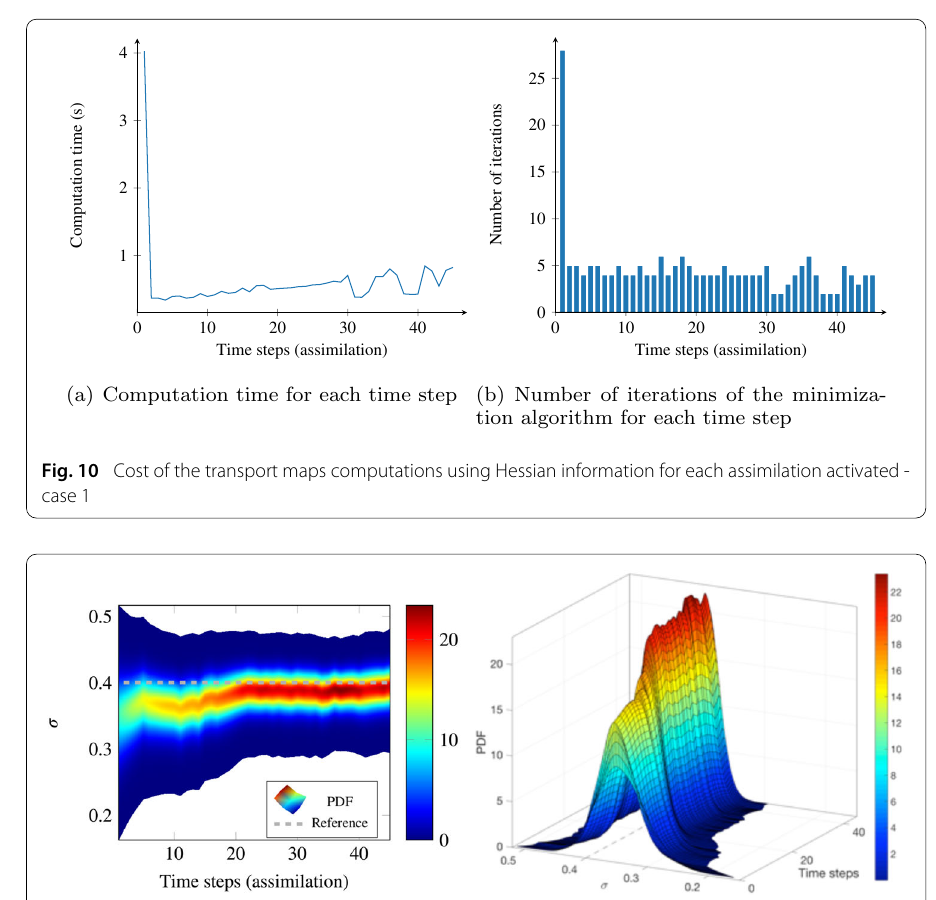
Fig. 11 Marginals on σ computed with 20,000 samples and kernel density estimation for each assimilation time step - Case